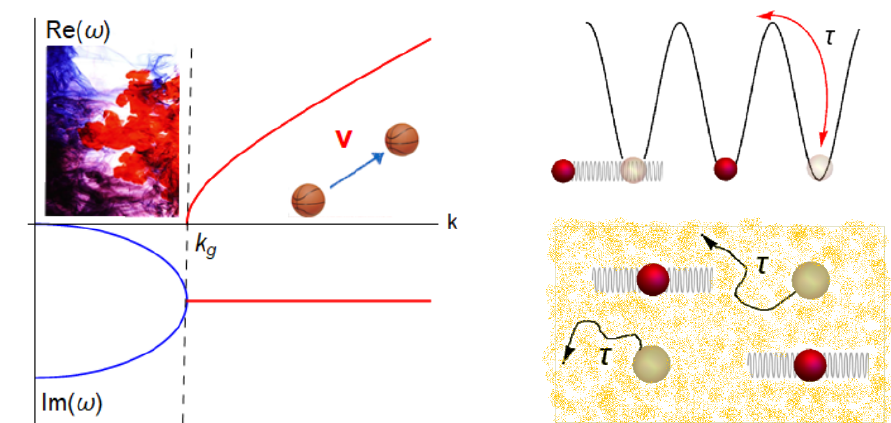
Figure 5: Left: The phason dispersion relation arising from the hydrodynamic de- scription of quasicrystals [ 43 ] . The upper half plane is the real part and the lower the imaginary part. The blue color indicates the diffusive regime while the red one the propagating one. k = k is the crossover point known as k − gap. Right: The g dynamics from the energetic point of view and in the physical space. The jumps in the potential correspond to te re-arrangement in the physical space of the quasicrys- tal. The time τ is either the average jump time or the average time of molecular